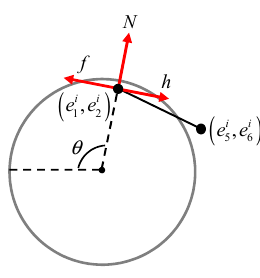
Figure 2. Forces acting on a rope.